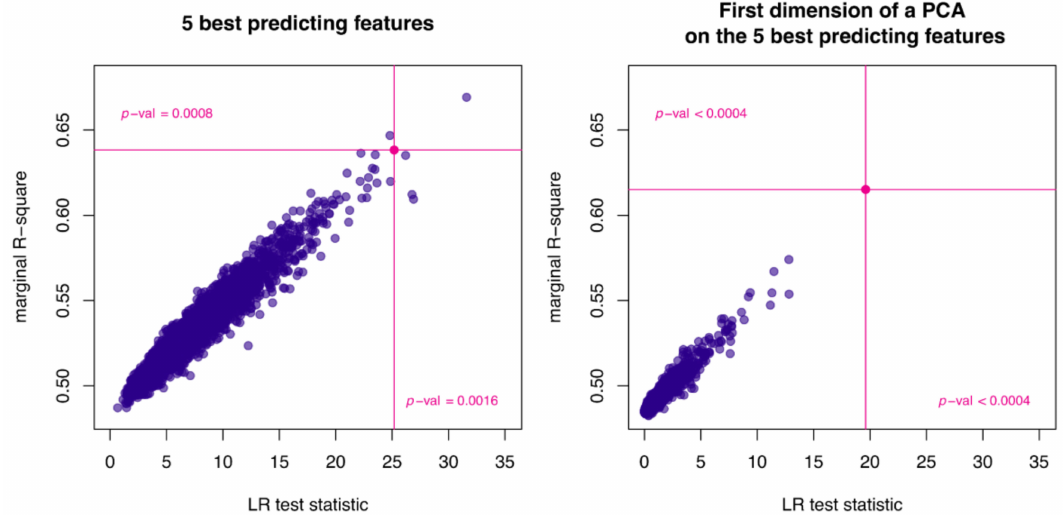
Figure 4. The relationship between the marginal R-squared and likelihood ratio statistics obtained when using the five most predictive features directly ( left ) or using the radiomics signature described in Equation (1) ( right ). The statistics derived from the real features are shown as pink lines, those from simulated features are shown as 2500 blue dots corresponding to 2500 simulated sets of random predictors (as described in Section 4). The proportion of blue dots in the upper right quadrant of each plot is less than 1% of the total and therefore the null hypothesis, that the observed dataset of radiomic features has no predictive power for the response variable log(ctDNA maf ), can be